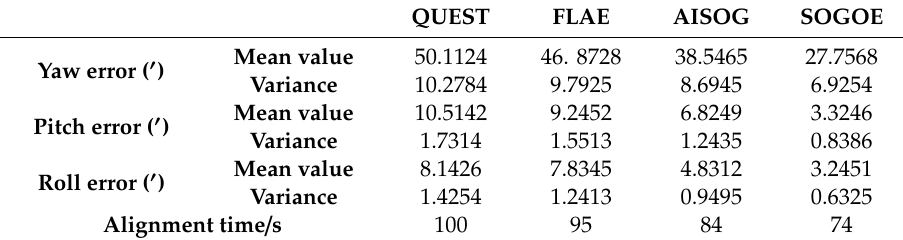
Figure 10 . The attitude angle errors of the three alignment methods. Figure 10. The attitude angle errors of the three alignment methods. Table 8. Comparison of the attitude angle error and alignment